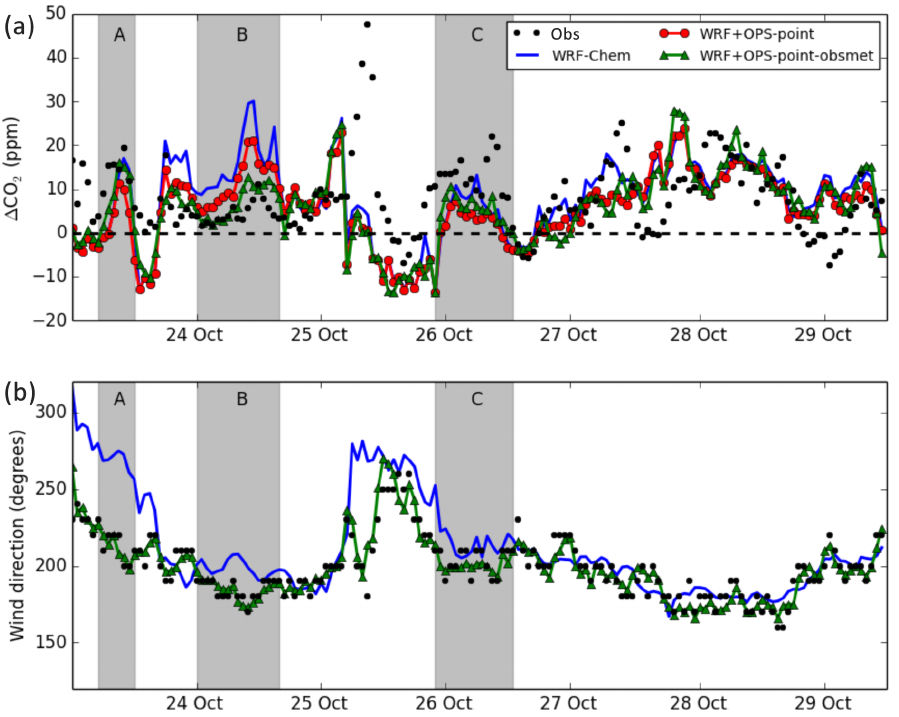
Figure 7. Time series of (cid:49) CO 2 at Zweth from observations and three model simulations (a) and of the wind direction at Rotterdam airport from WRF-Chem, WRF + OPS-point-obsmet and observations (b) . Shaded areas indicate specific events discussed in more detail in the